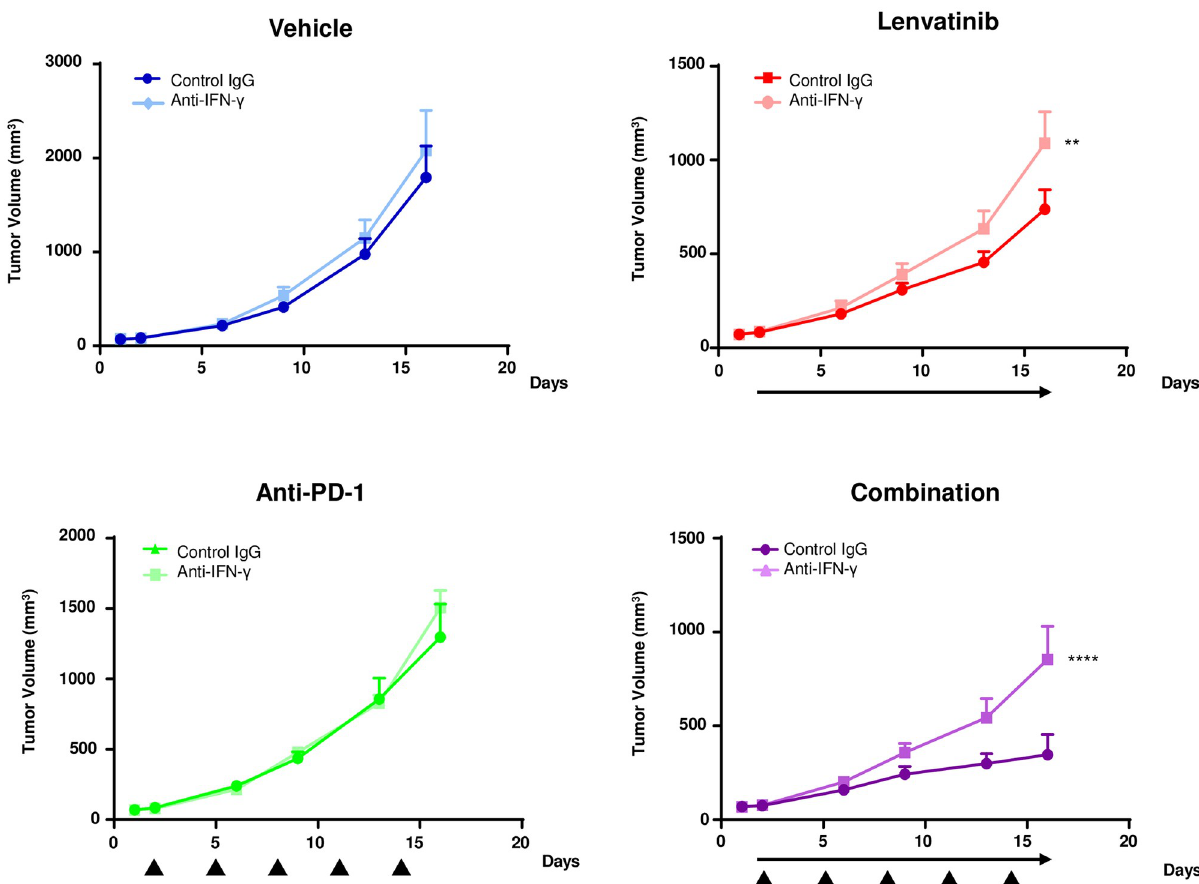
Fig 6. Antitumor activity of lenvatinib under IFN- γ -inhibited conditions in the CT26 model. A. Mice, inoculated with CT26 cells, were treated with anti-IFN- γ antibody or control IgG on Day 8 after CT26 inoculation and twice weekly thereafter. The mice were randomized into groups of 7 with an average tumor volume size (Day 1 mean TV 71.1 mm 3 ). The day after the first injection of anti-IFN- γ antibody or control IgG, mice were treated with vehicle (control IgG, dark blue; anti-IFN- γ antibody, light blue), 10 mg/kg lenvatinib (control IgG, dark red; anti-IFN- γ antibody, light red), anti-PD-1 (control IgG, dark green; anti-IFN- γ antibody, light green) or combination (control IgG, dark purple; anti-IFN- γ antibody, light purple). Lenvatinib treatment is indicated by the black arrow, and anti-PD-1 treatment is indicated as black triangles. Error bars represent the SEM. �� P < 0.01, ���� P < 0.0001, Dunnett’s test vs. control IgG (n = 7).